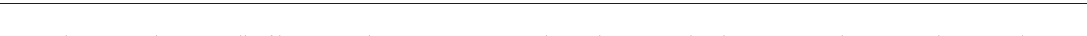
Fig. 1 A transient IOP elevation induces T-cell in fi ltration and progressive RGC and axon loss. a IOP levels in MB- or saline-injected B6 mice ( n = 18/group). b Retinal T-cell in fi ltration post MB injection. Retinal fl at-mounts from mice 3 weeks after MB injection were stained with Tuj1 (red), an anti-CD3 antibody (green; arrow), and DAPI (blue). Scale bar: 10 µ m. c Quanti fi cation of CD3 + T cells in retinas of uninjected mice (U), mice 3 weeks after saline injection